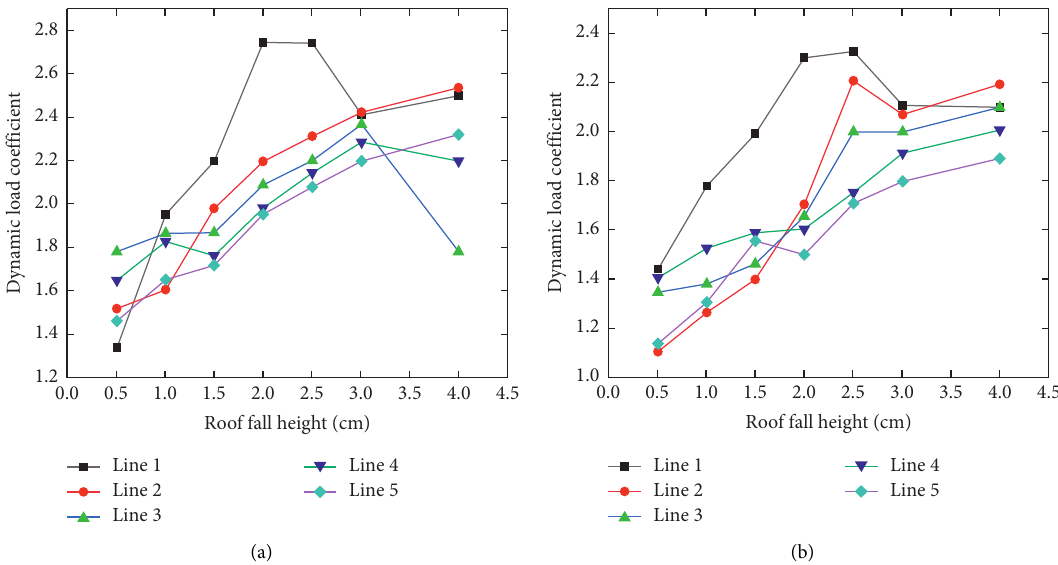
Figure 5: Dynamic load coefficient at different positions and heights of roof fall: (a) large-cutting-height face; (b) top-coal-caving